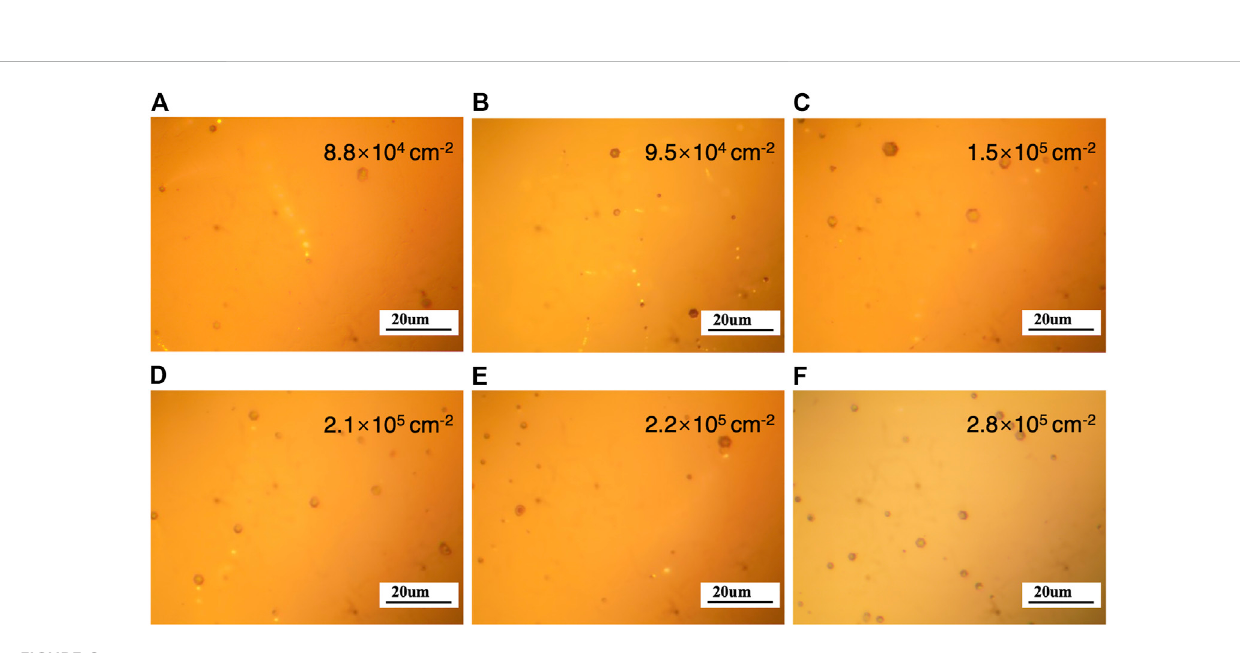
FIGURE 6 Opticalmicrographsofthe (A,D) Φ 51, (B,E) Φ 62,and (C,F) Φ 75 mmsubstratesafterpreferentialwetchemicaletchingineutecticKOH/NaOHsolutionat 360 ° C for 5